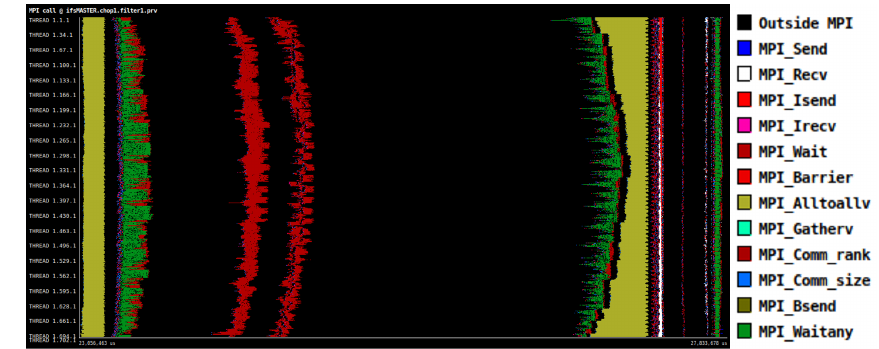
Figure B1. Example of a trace with MPI call events. The timeline is on the x axis, and MPI processes are on the y